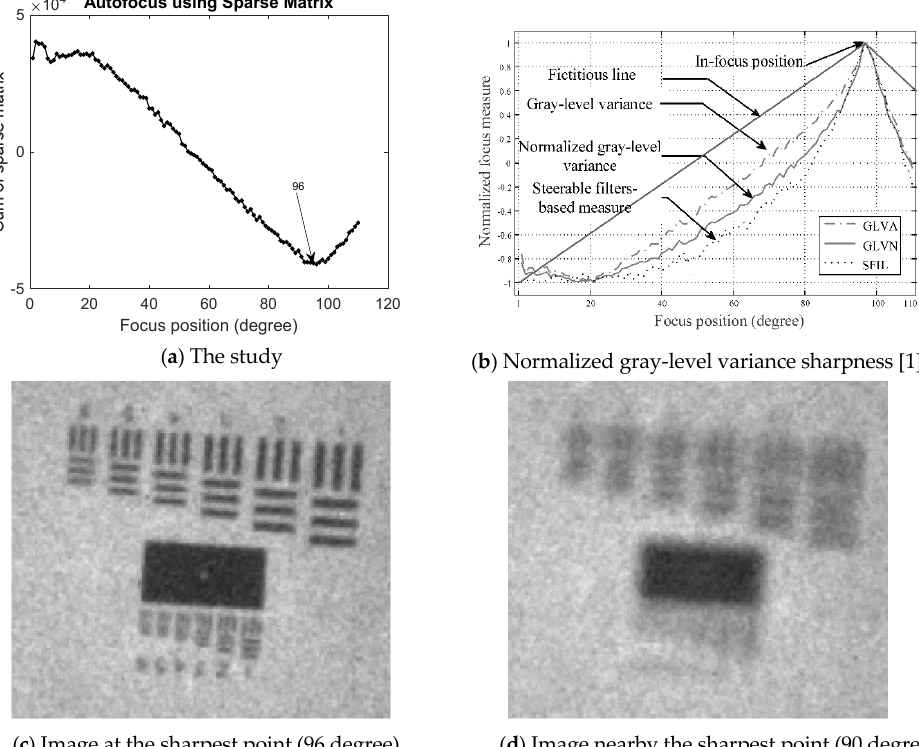
Figure 19. Result comparison of this study and normalized gray-level variance sharpness method under correct focal distances.